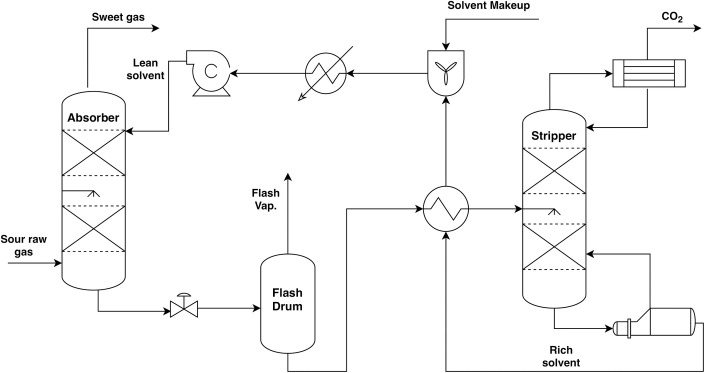
Scheme of the natural gas sweetening process.